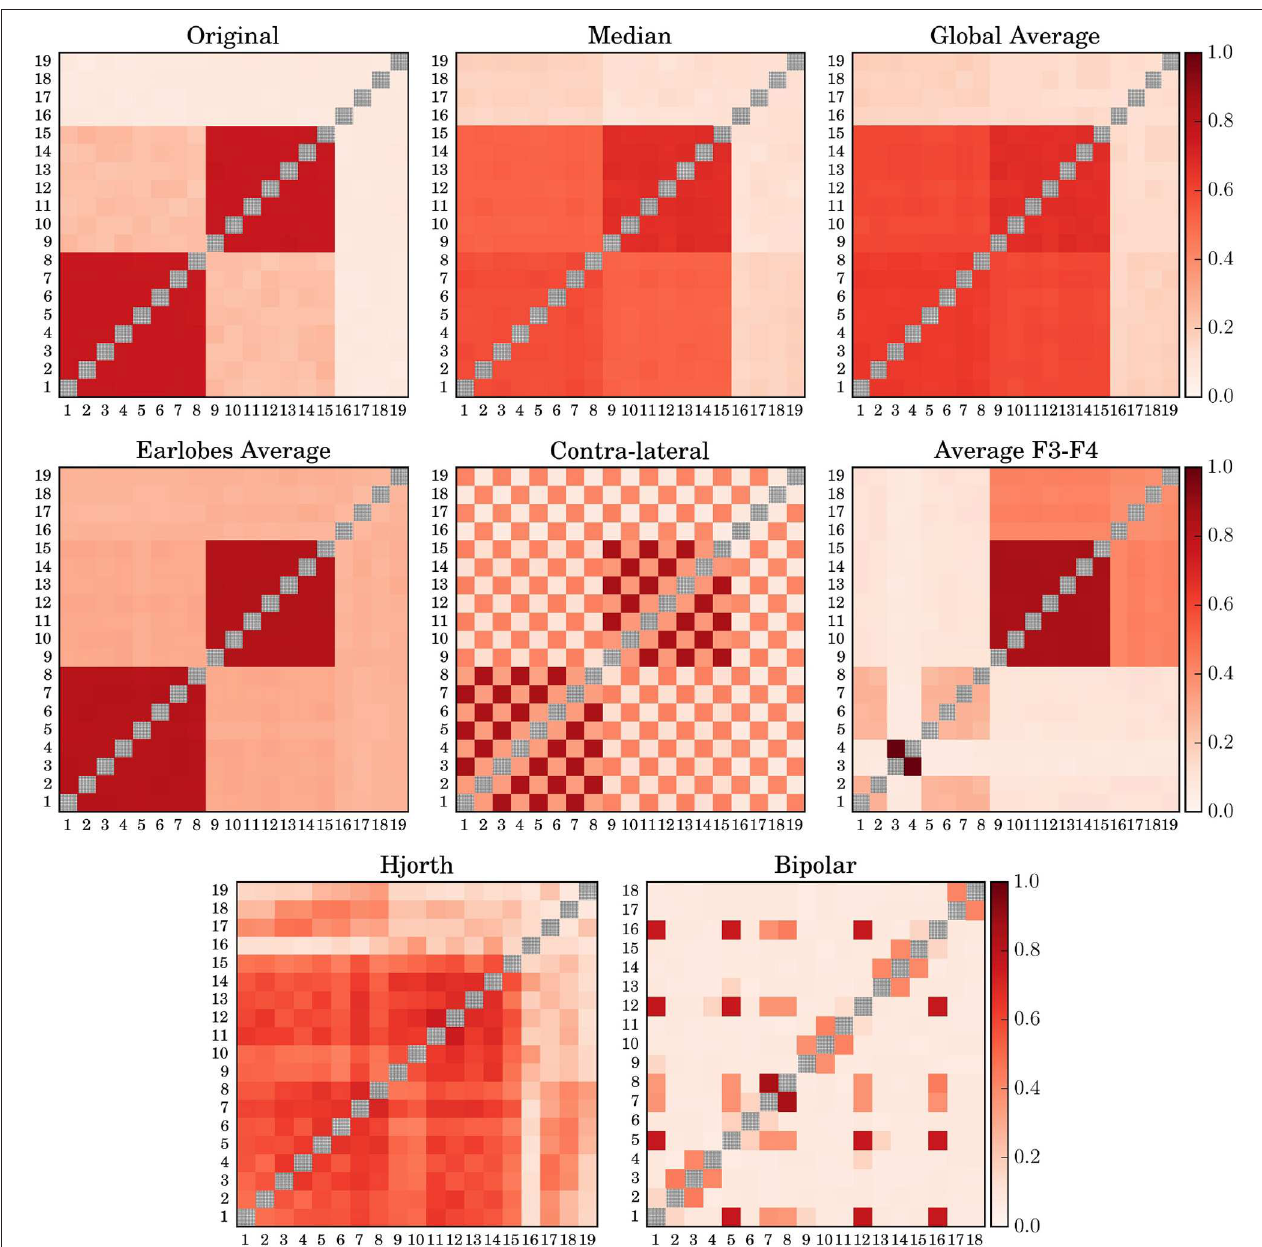
FIGURE 2 | Average Mean Phase Coherence matrices derived for model 7 by using different simulated EEG references. The diagonal elements of all matrices are drawn in gray in order to improve